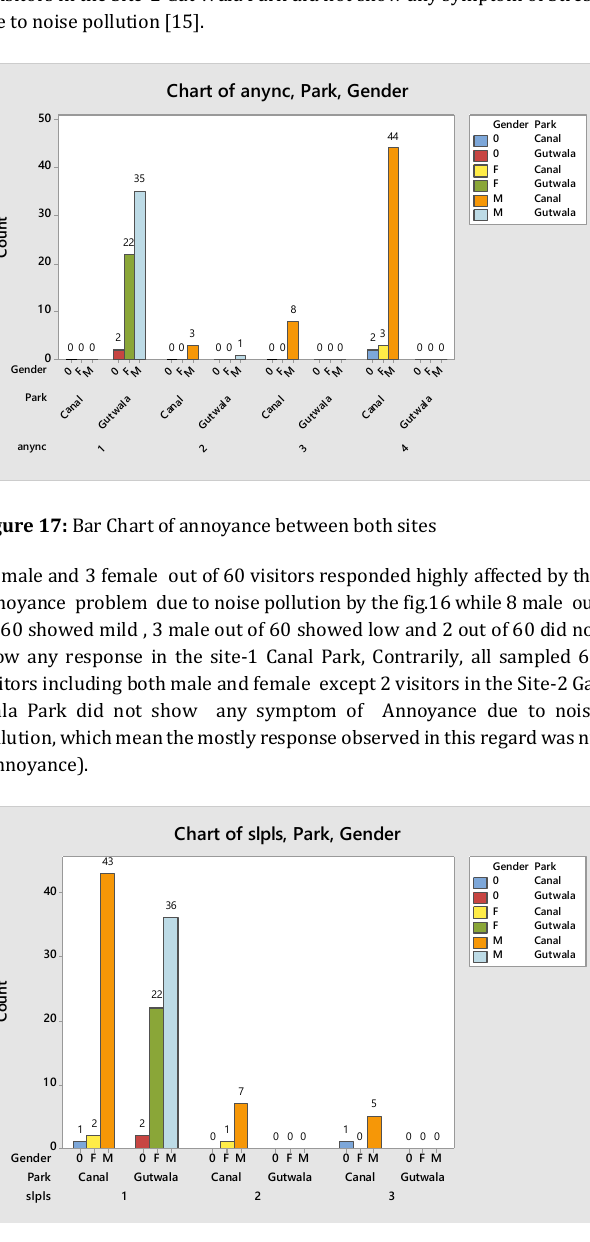
Figure 16: Bar Chart of Stress problem between both sites 4 males out of 60 visitors responded highly affected by the stress problem